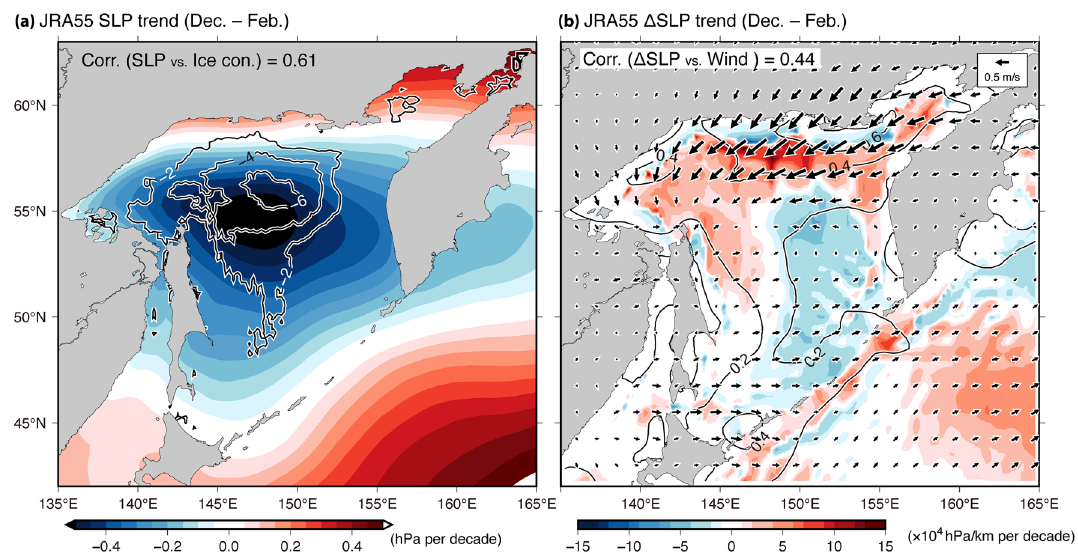
Figure 7. Linear trend maps of ( a ) JRA55 SLP (color) and ( b ) its horizontal gradient (ΔSLP, color) during winter. ( a ) Contours show the linear trend for NOAA OI ice concentration (% per decade) (i.e., same as contour of Fig. 5b). ( b ) The linear trend of JRA55 surface wind field is shown by contours and vectors (ms –1 per decade) (same as contour of Fig. 5a except for the vector). The vectors were scaled as indicated in the top right corner of the panel. The correlation coefficients (significant at 99% confidence level according to a t -test) for spatial variation of trend values with each grid between ( a ) the ice concentration and SLP, and ( b ) the surface wind and ΔSLP (i.e., between contour and color for each panel) are shown in the top left corner of both panels. Note that the correlation coefficient was calculated only using the grid data over the SO, where the distance from the land was > 100 km and where the climatological ice concentration (NOAA OI ice concentration) during the winter was >